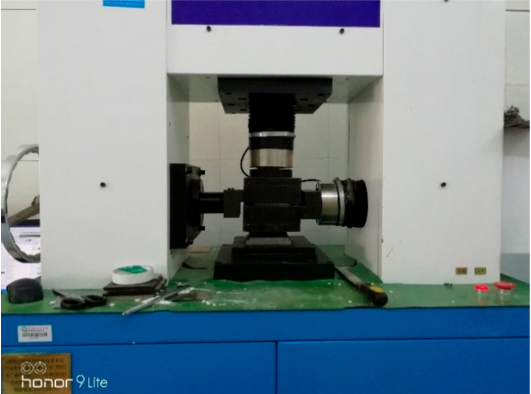
Figure 10. YZW-30A microcomputer-controlled electronic shear system for joint specimens.